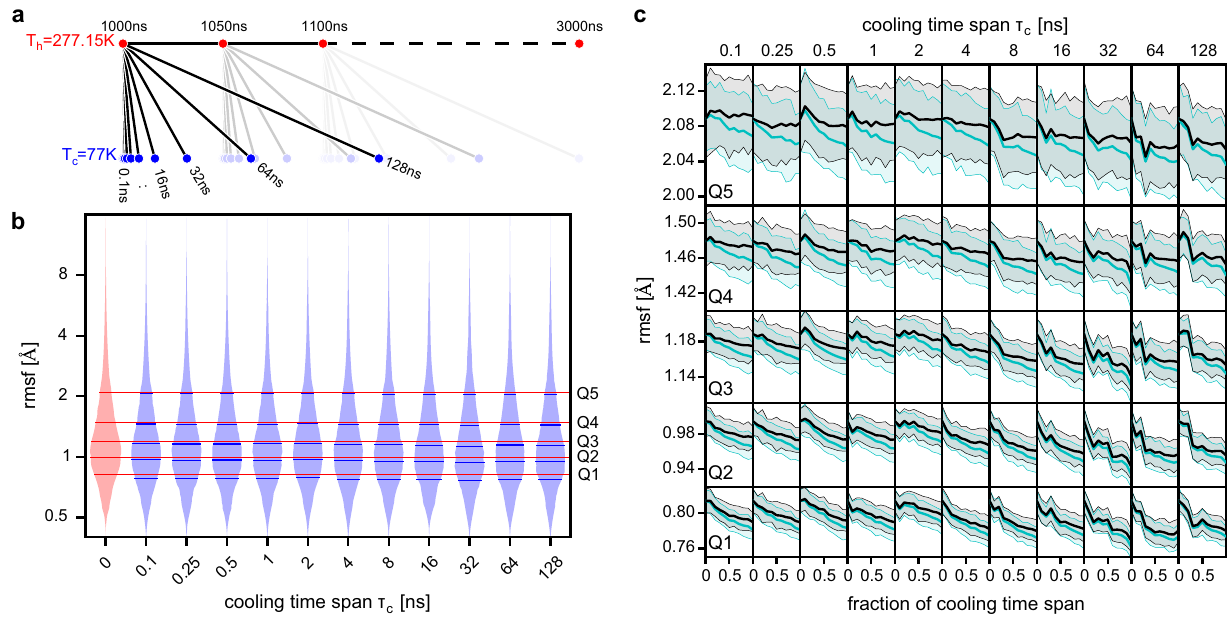
Fig. 2 Effects of different cooling rates in T-quench MD simulations. a Schematic of T-quench simulation protocol. From a trajectory of the ribosome ⋅ EF- Tu complex at T = 277.15 K, 41 snapshots were extracted (1000 – 3000 ns, every 50 ns). From these snapshots, T-quench simulations of different lengths (cooling time span τ c 0.1 ns to 128 ns) were started with linearly decreasing temperature from 277.15 K to 77 K. b Histograms of the root mean square fl uctuations (rmsf) of the heavy atoms of the ribosome ⋅ EF-Tu complex obtained from ensembles of 41 snapshots. The histogram for the ensemble before cooling is shown (light red area). Red horizontal lines show the 6-quantiles (Q1 – Q5). For each cooling time span τ c , the rmsf histogram of the ensemble of the fi nal snapshots of the 41 cooling simulations is shown (light blue area) with 6-quantiles (horizontal blue lines). c Rmsf quantiles are shown as a function of the simulation time before (mean value: cyan line, standard deviation: light cyan area) and after rescaling the conformations (black line, gray